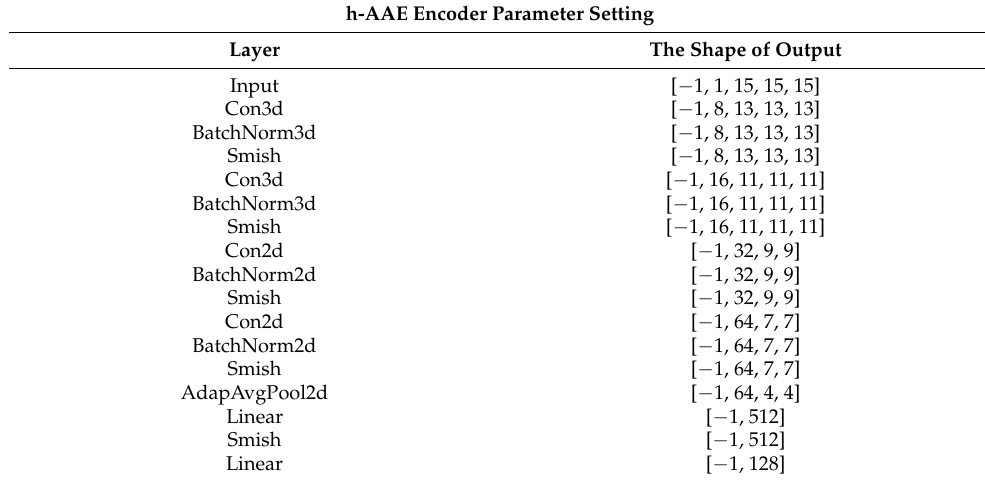
Table 2. The shape of layers in the h-AAE model for encoding.